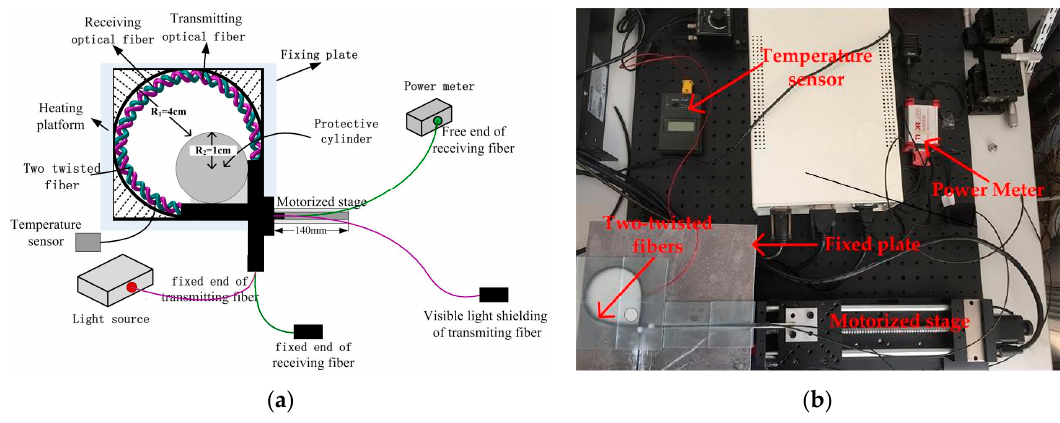
Figure 1. System of wide-range displacement sensor ( a ) and Displacement sensor experiment device ( b ).